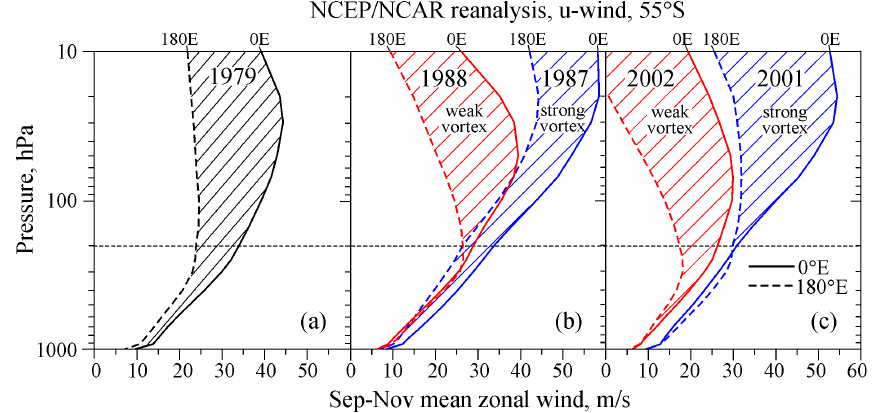
Fig. 4. Vertical profiles of the September-November mean zonal wind in 1979 (a) , 1987/1988 (b) and 2001/2002 (c) . To illustrate a degree of the wind zonal asymmetry, the two opposite points of the latitude circle 55 ◦ S are presented, 0 ◦ E (solid curves) and 180 ◦ E (dashed curves). The weak and strong vortex years are marked by the red and blue lines,